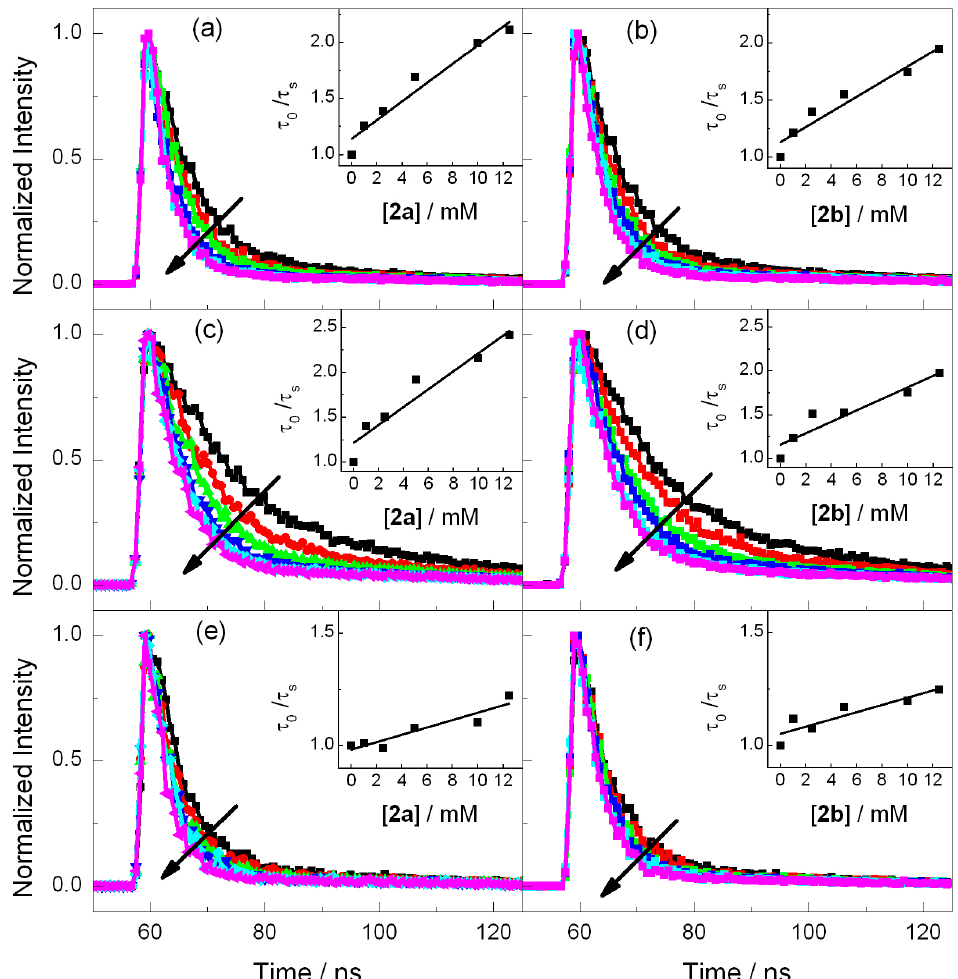
Figure 3. Fluorescence kinetic traces obtained for DCN ( λ exc = 310 nm) ( a , b ), DCA ( λ exc = 375 nm) ( c , d ) and CNN ( λ exc = 310 nm) ( e , f ) in the presence of increasing amounts of 2a (left panel) or 2b (right panel) from 0 to 12.5 mM. Inset: corresponding Stern Volmer plots. The quencher concentration is 0 (black), 2.5 (red), 5 (green), 7.5 (blue), 10 (light blue) and 12.5 mM (pink).